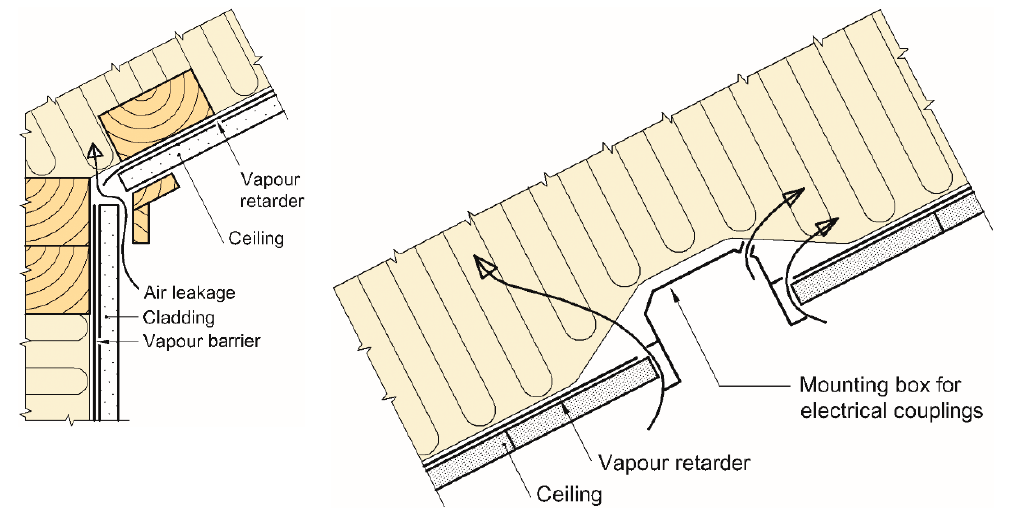
Figure 8. Examples of typical air leakage paths through the vapour retarder [20].